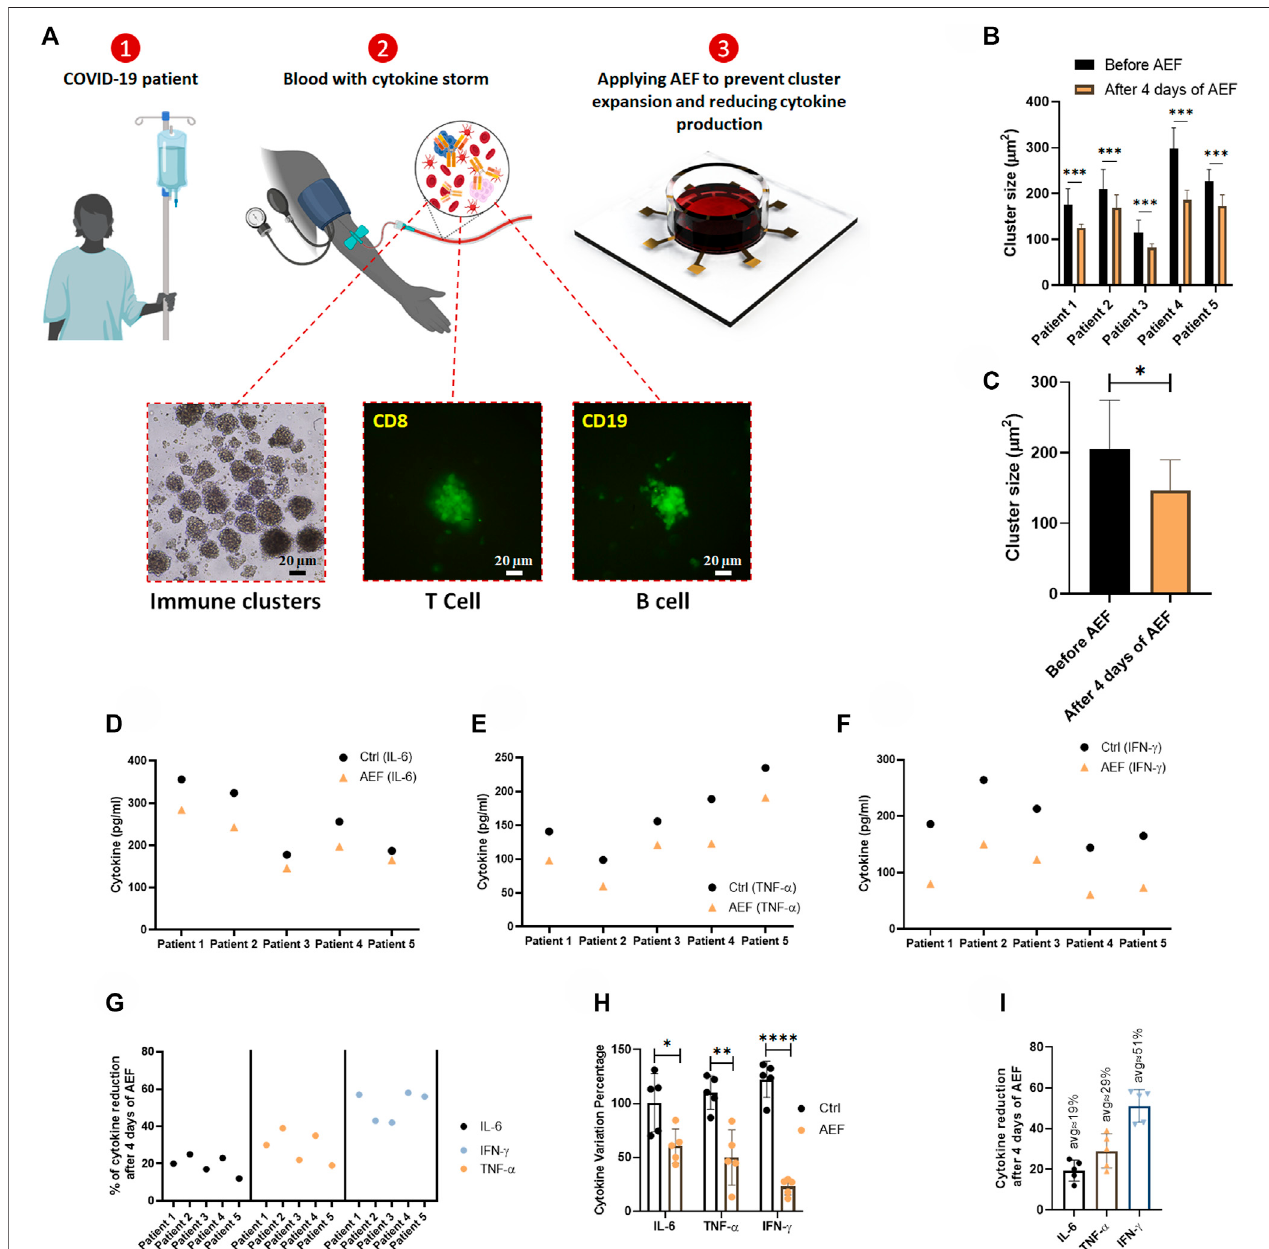
FIGURE 5 | (A) The whole blood sample was obtained from COVID-19 patients, and the PBMCs were isolated using the density gradient centrifugation method. Immuno fl uorescence imaging con fi rms the activation and the expansion of lymphocytes in these blood samples. The lymphocytes were cultured in blood serums and werestimulatedbyAEF for 4 days. (B, C) Signi fi cant differences wereobservedin thesize oflymphocyteclustersafter 4 days ofAEFstimulationfor COVID-19 patients ’ PBMCs. (D – F) The concentration of in fl ammatory cytokines in COVID-19 patients ’ blood serum, which their PBMCs were cultured, for control and AEF exposed groups. (G) Percentage of cytokine reduction in COVID-19 patients ’ blood serum caused by AEF stimulation. (H) Comparing the cytokine variation percentage for the three cytokines of IL-6, TNF- α and IFN- γ after 4 days ofincubation for both groups ofcontrol and AEF with respect to the primary sample. (I) The average percentage of cytokine reduction in COVID-19 patients ’ blood serum after 4 days of exposure to AEF. (* p < 0.05, ** p < 0.01, *** p < 0.001, and **** p < 0.0001, t-test).